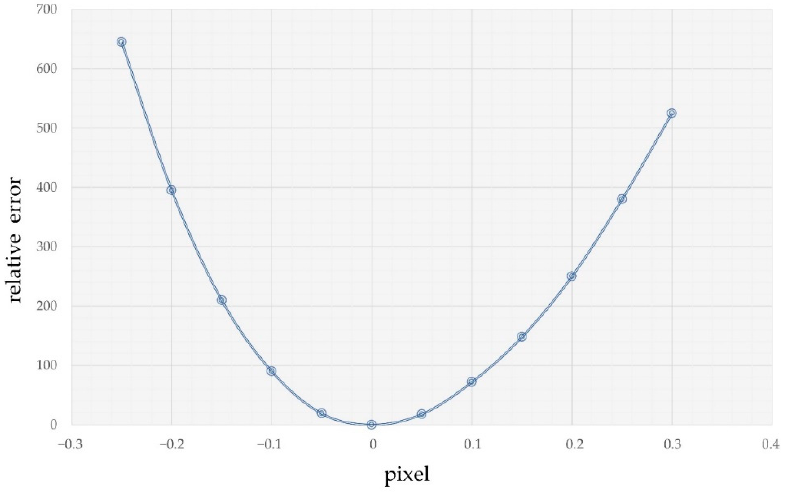
Figure 3. Relative error corresponding to template movement near the centroid of the spot.